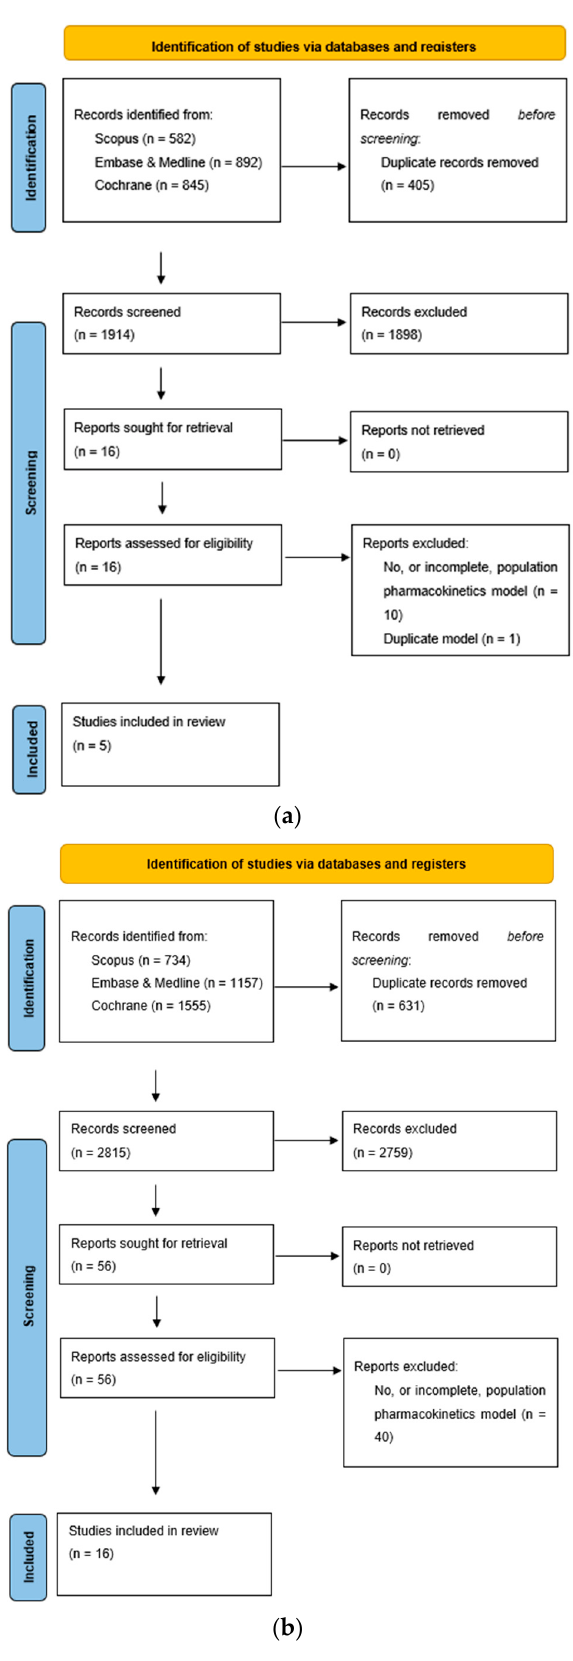
Figure 1. ( a ) PRISMA flowchart for apixaban population pharmacokinetic studies; ( b ) PRISMA flowchart for rivaroxaban pharmacokinetic studies.